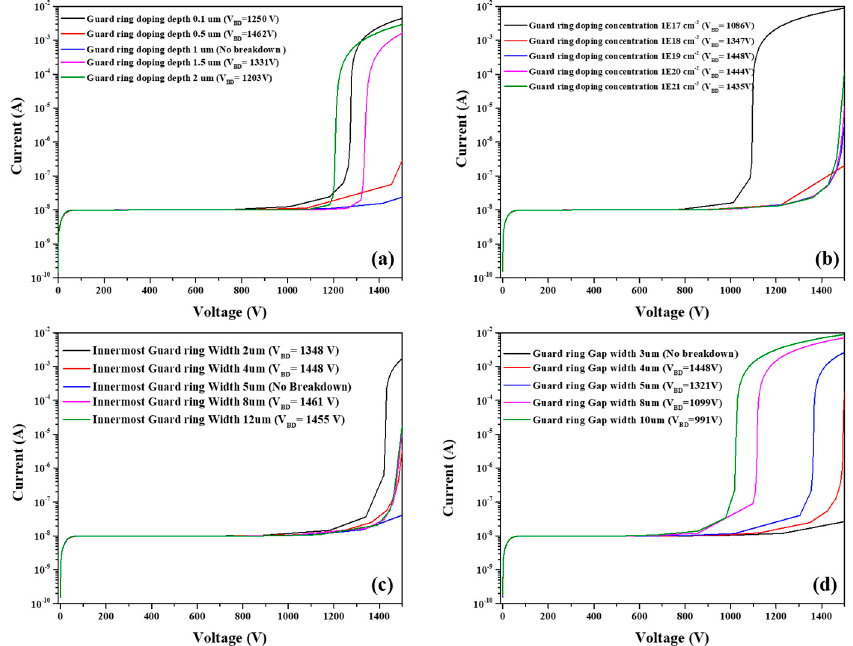
Figure 8. The simulation of I–V curves for the different guard ring parameters: ( a ) guard ring doping depth, ( b ) guard ring doping concentration, ( c ) innermost guard ring width, and ( d ) gap width between the active area and innermost guard ring. The optimal innermost guard ring width and gap width were 5 μ m and 3 μ m, respectively.